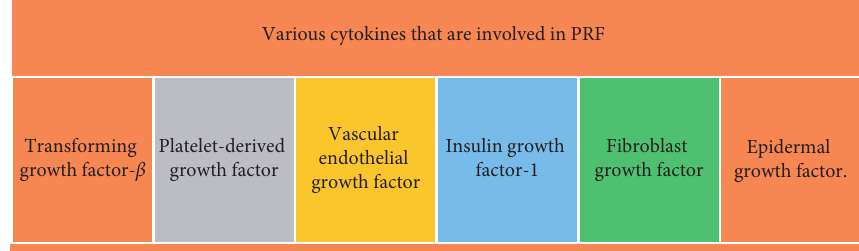
Figure 1: The various cytokines that are involved in PRF.